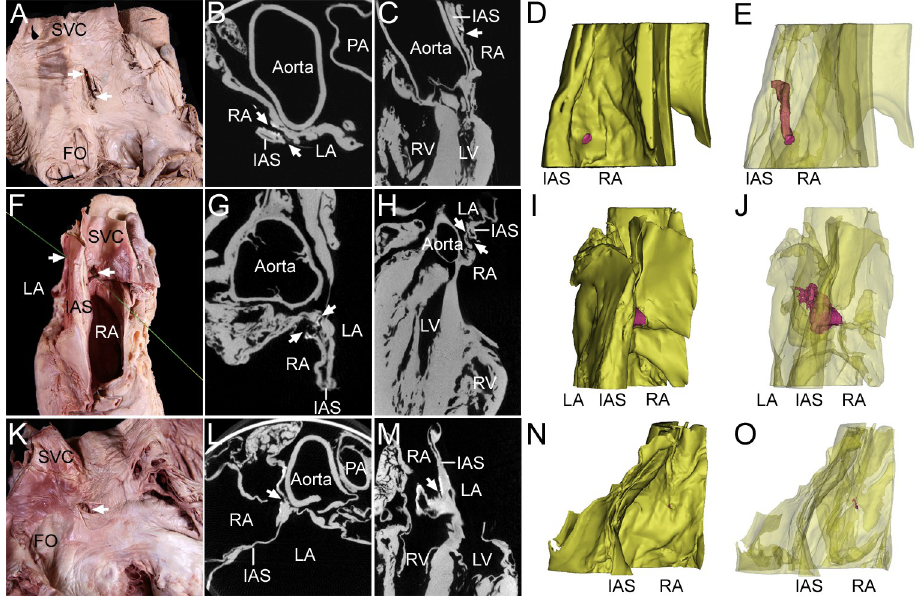
Fig 2. Classification of the IAC in dissection images, micro-CT Images, and 3D models. In two specimens of an open channel (one specimen for A-E, the other specimen for F-J), the holes (arrows) on the two sides were found to be connected to each other via a tortuous channel in dissection images (A, F), axial-plane micro-CT images (B, G), sagittal-plane micro-CT images (C, H), and 3D models (D, E, I, and J). In a specimen of an obstructed channel (one specimen for K-O), holes (arrows) on the two sides were not connected in a dissection image (K), axial-plane micro- CT image (l), sagittal-plane micro-CT image (M), or 3D model (N, O). In the 3D model, the yellow structure is the interatrial septum (IAS) and the red structure is the IAC. The model was rendered semitransparently so that the entire channel passing through the IAS could be visualized. The same specimen was used for the dissection image, micro-CT images, and 3D model. For the specimen in panel A, light was allowed to shine through the open channel from the connected hole on the opposite surface. For the specimen in panel F, a thread was passed through the IAC to show the connection of each hole. The right atrium (RA) was opened. FO, fossa ovalis; LA, left atrium; PA, pulmonary artery; SVC, superior vena cava.